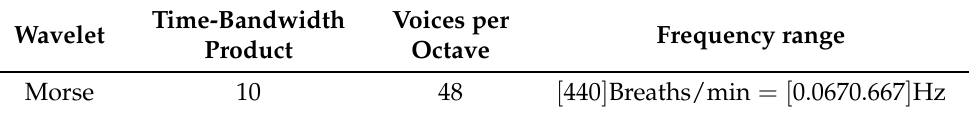
Table A5. Parameters for the